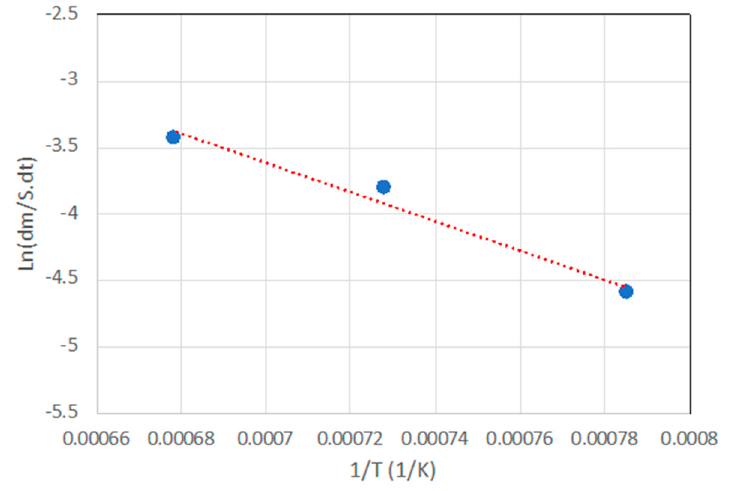
Figure 8. Arrhenius plot based on the data of Figure 7.